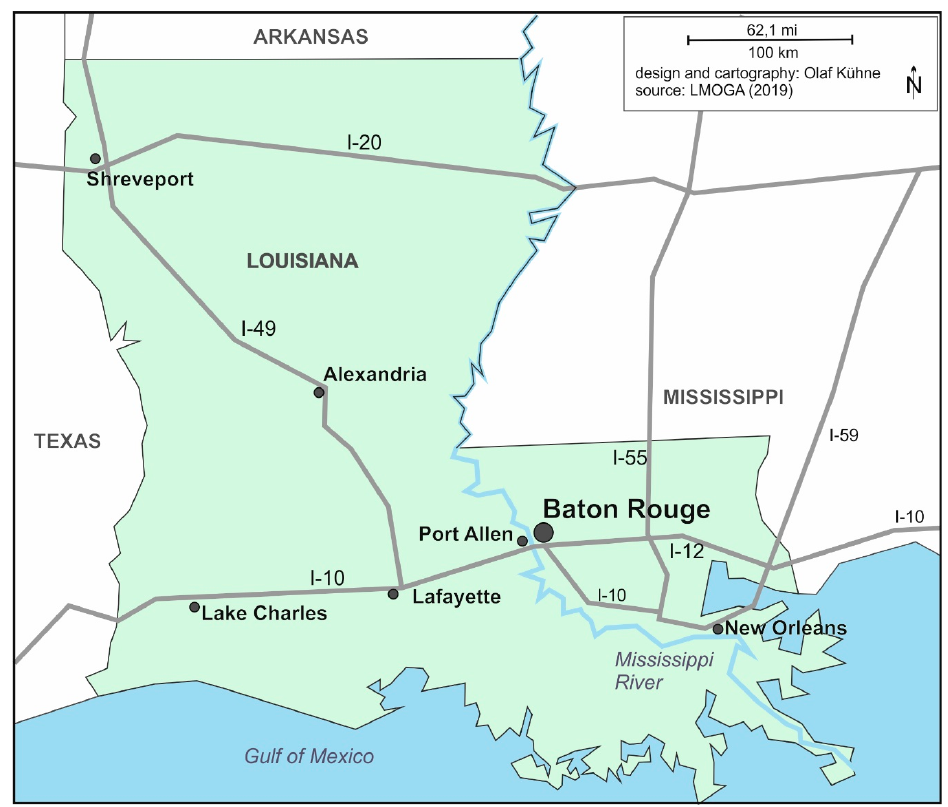
Figure 1. The spatial location of Baton Rouge in Louisiana (own illustration).